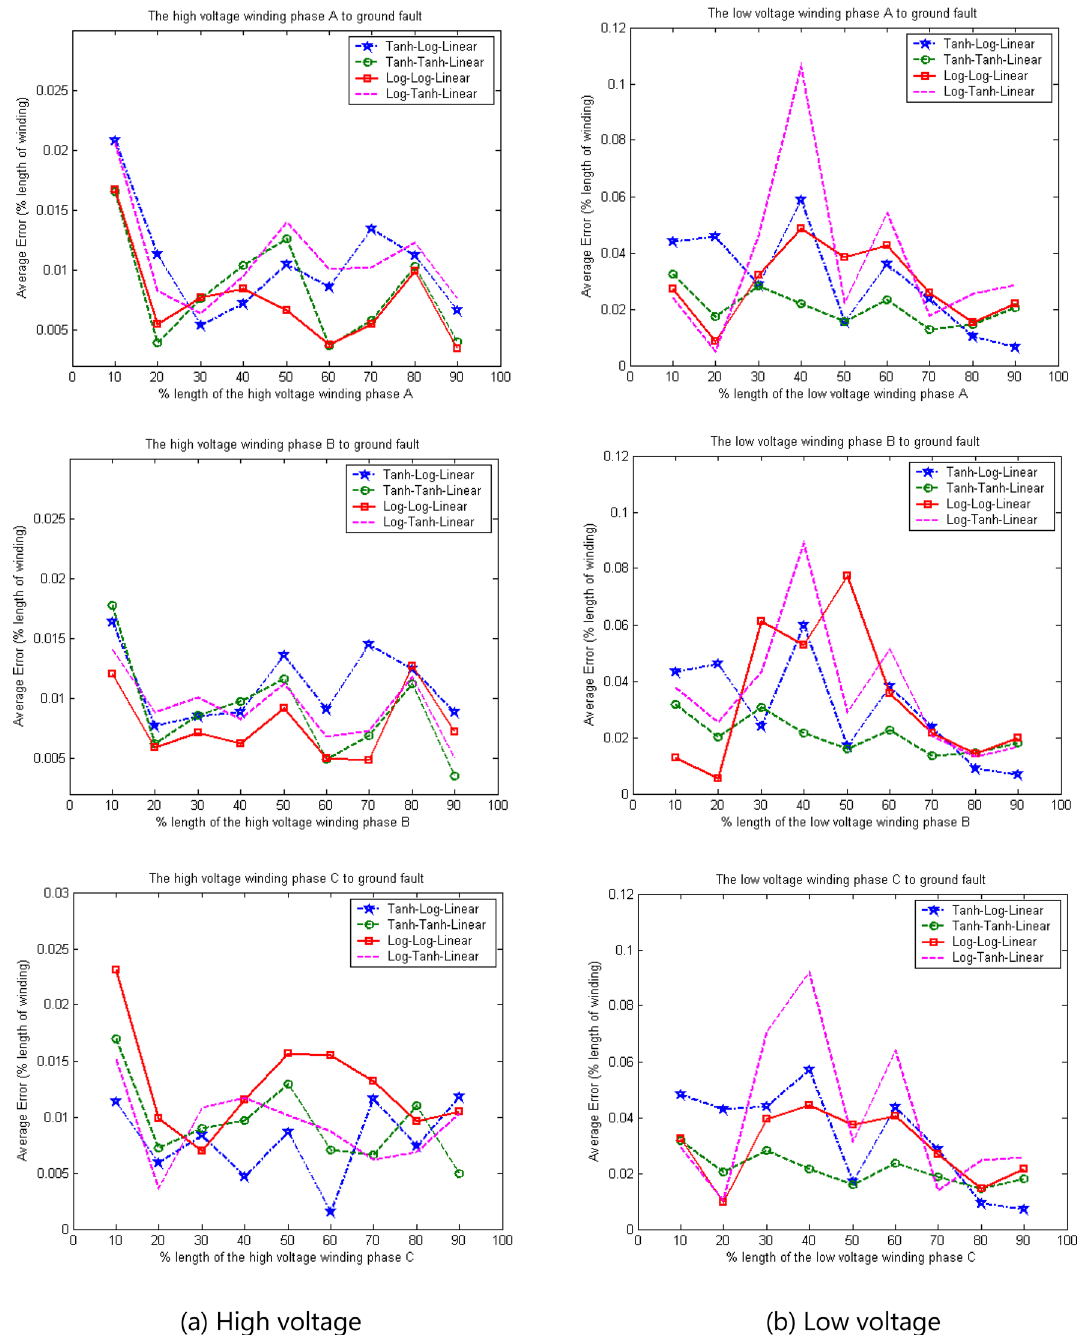
Figure 12. Average error in fault location using four optimal activation function